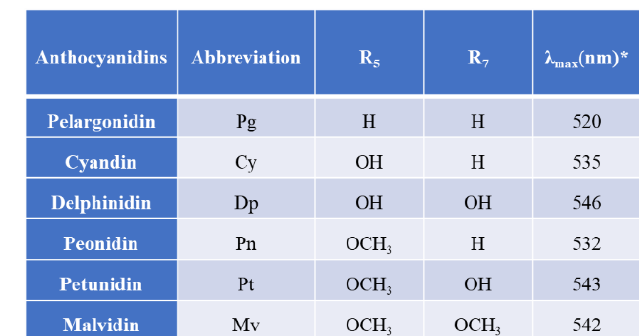
Figure 1. Chemical structures of six common anthocyanidins (flavylium form) and their sources based on current information. ( A ) Basic structure; ( B ), six common anthocyanidins. * indicates that λ max means the wavelength at which a substance has its strongest photon absorption.